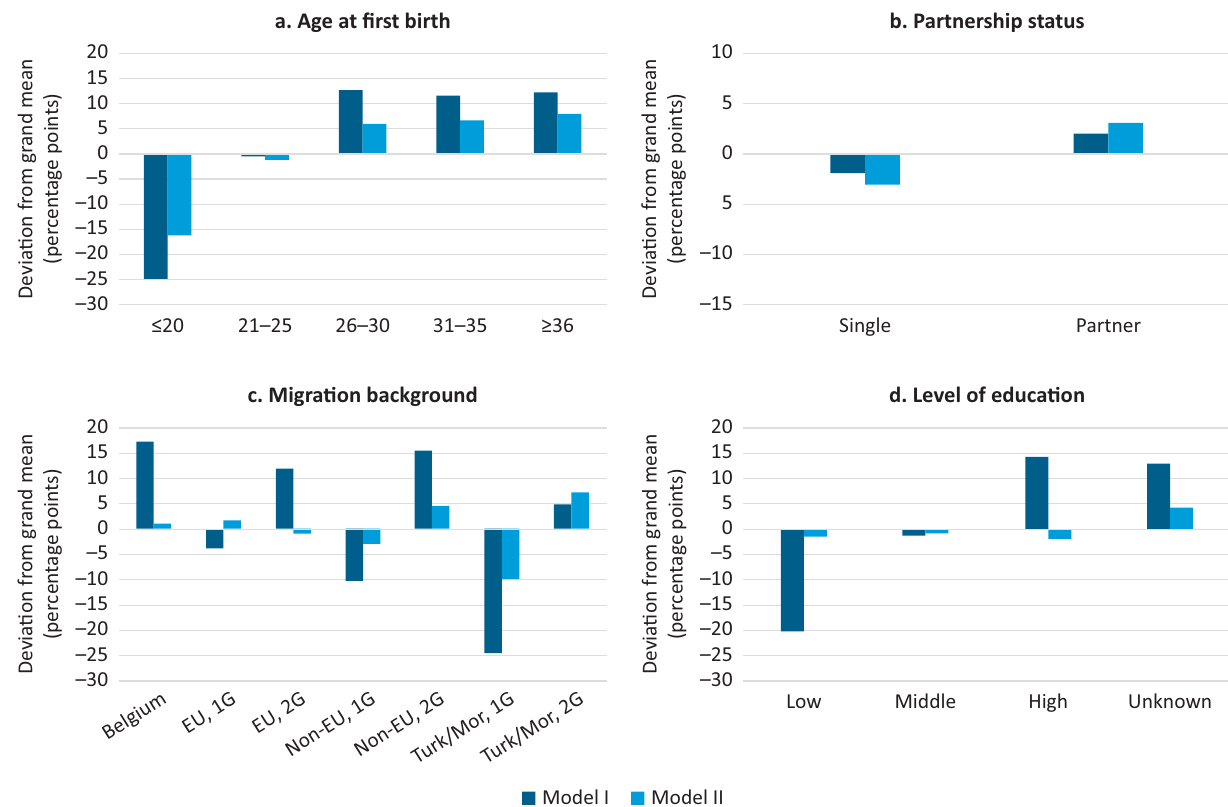
Figure 3. Predicted probabilities of leave uptake by age at first birth, parity, partnership status, migration background, and education before (Model I) and after (Model II) controlling for eligibility, expressed as deviations from the grand mean (assuming an average profile for other covariates; grand mean = 37%), 2000–2010. Source: BASD‐Panel, calculations by the